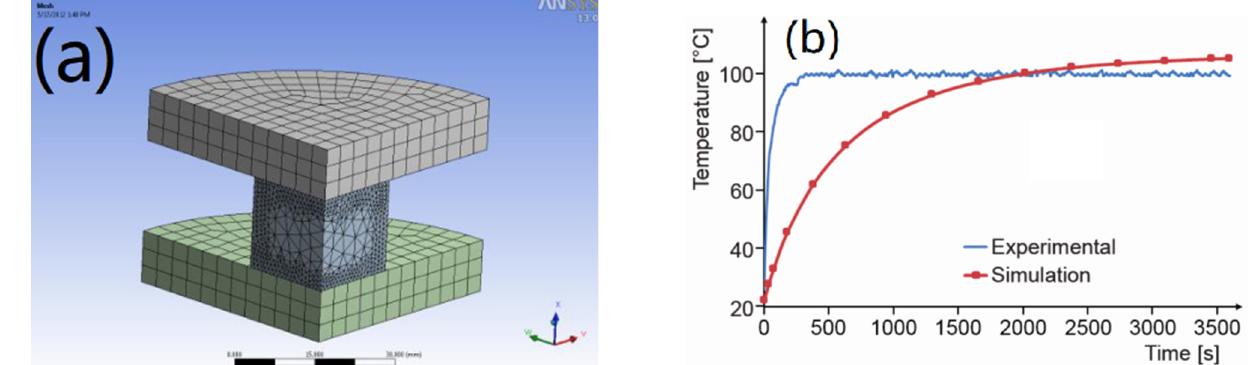
Figure 19. ( a ) FEM used in the verification process. ( b ) Comparison between experimental tempera- ture and predicted temperature at the center of rubber specimen [84].